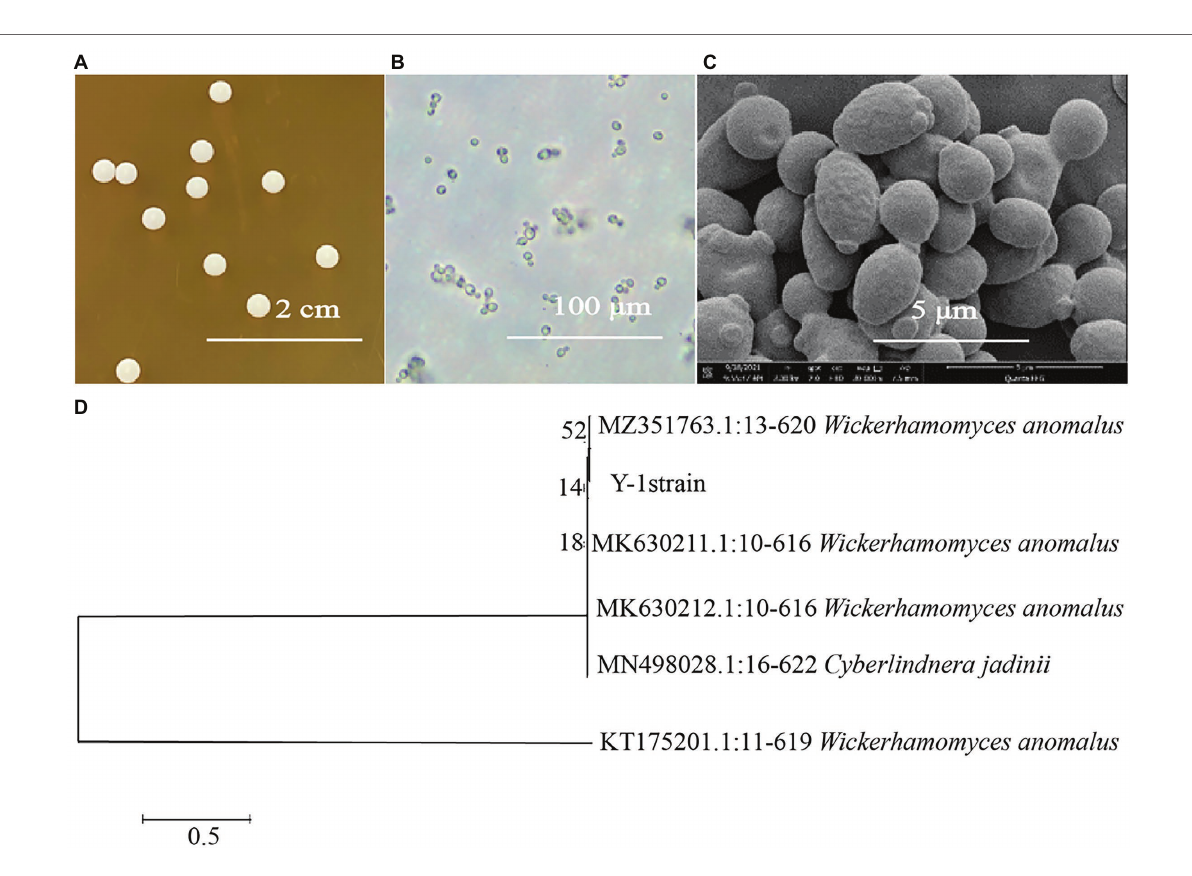
FIGURE 2 | (A) Y-1 colony morphology; (B) Y-1 morphology under the microscope; (C) Y-1 morphology under the scanning electron microscope; and (D) A neighbour phylogenetic tree of Y-1 and 5 strains with high homology was established based on the 18S rDNA fragment of